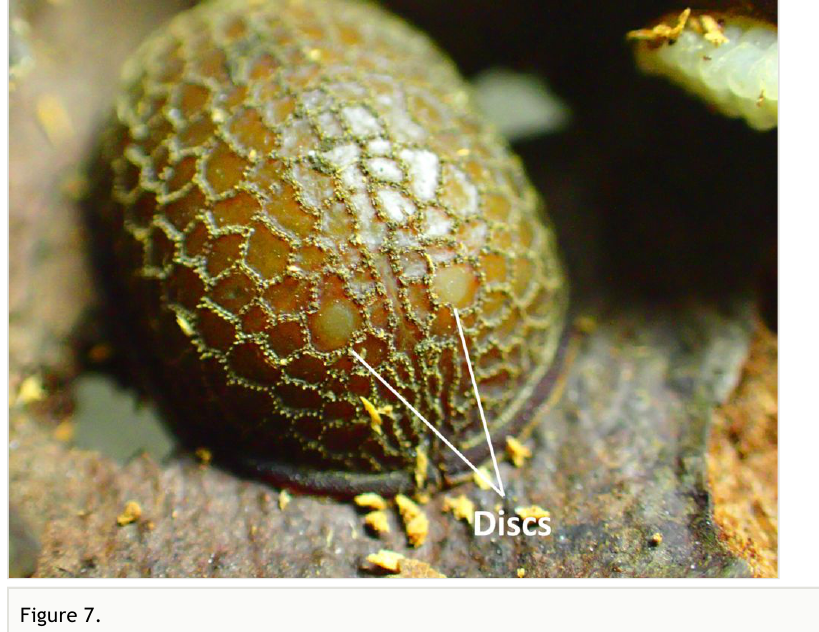
Figure 7. A pair of discs on the dorsal front part of the prepupa.